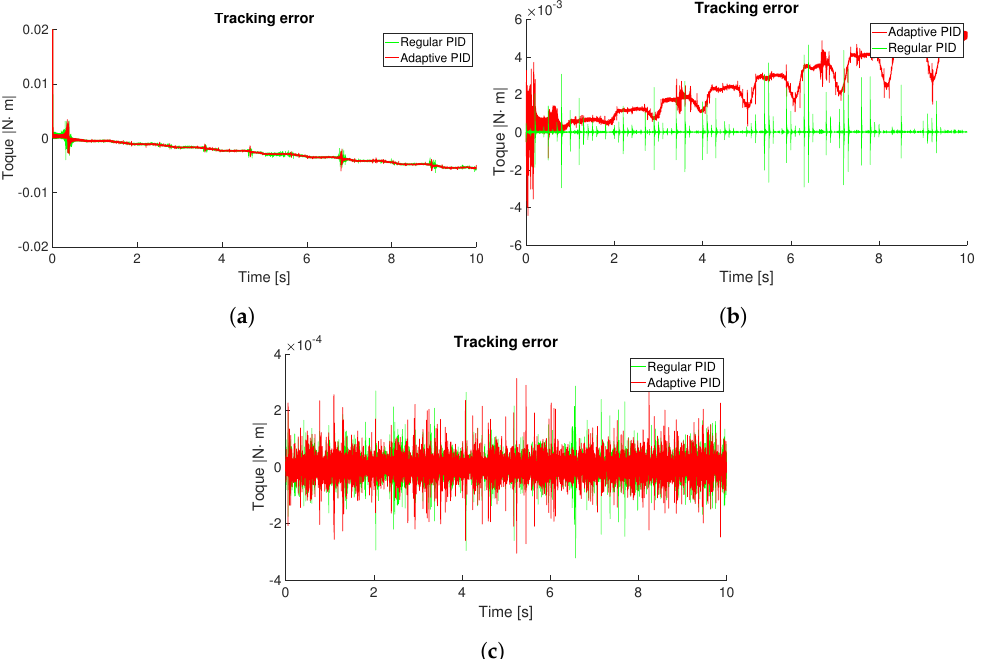
Figure 9. Torque evolution obtained with the application of a regular PID controller (green) and the proposed adaptive controller (red) for the hip ( a ), knee ( b ) and ankle ( c ).